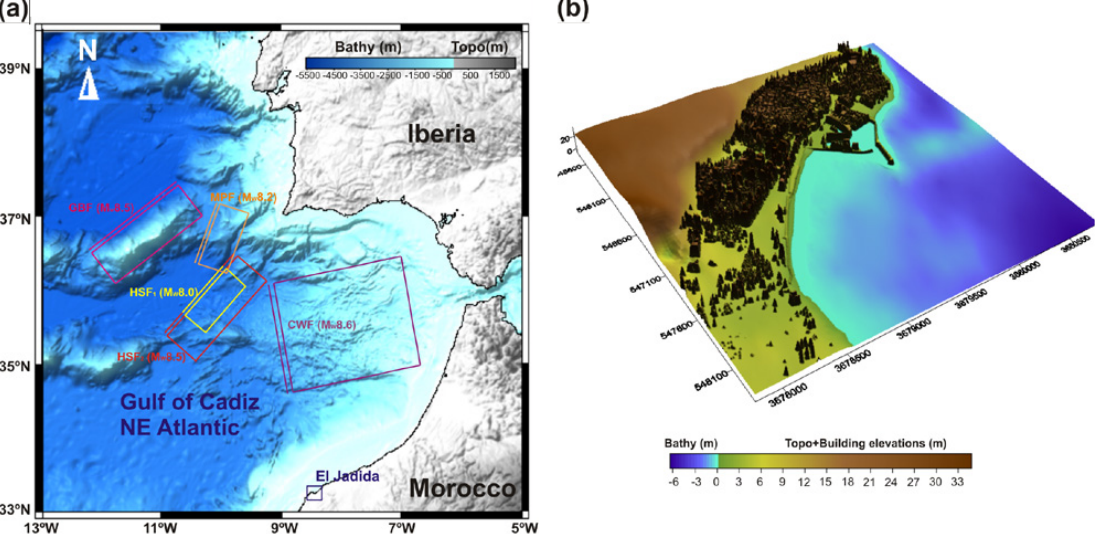
Fig. 4. Tsunamigenic scenarios and digital elevation models: (a) regional bathy/topo of the Gulf of Cadiz region and the considered tsunami scenarios, GBF: Gorringe Bank fault, MPF: Marques de Pombal fault, HSF: Horseshoe fault, CWF: Cadiz Wedge fault; (b) 5m resolution digital elevation model incorporating bathymetric, topographic and coastal buildings and sea-defense infrastructures data for the El Jadida